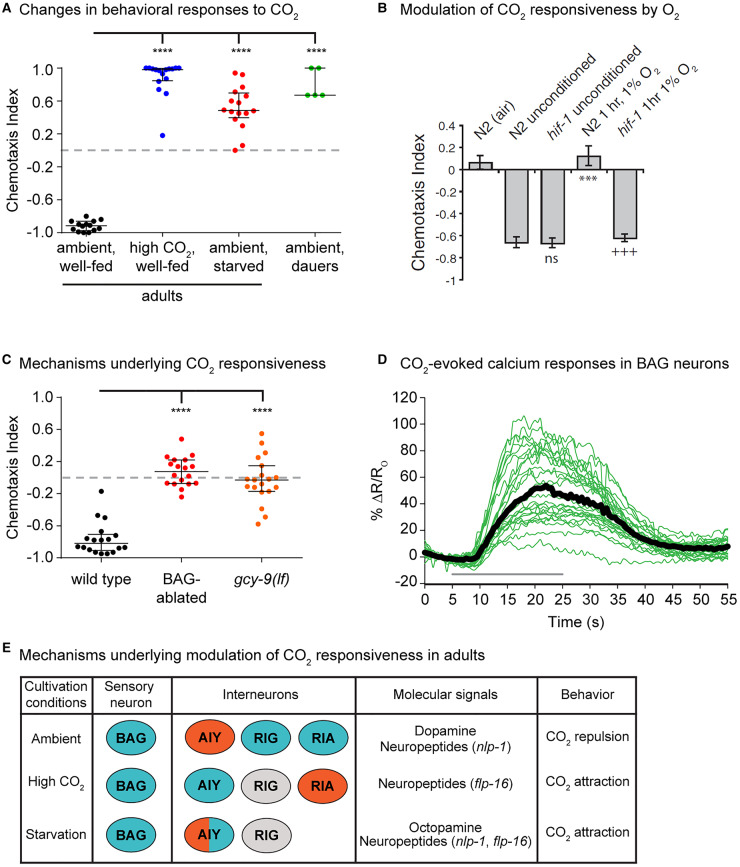
Behavioural responses of C. elegans to CO2. (A) Responses of wild-type C. elegans adults and dauers to CO2 in a chemotaxis assay (Fig. 1A). Dauers are developmentally arrested third-stage larvae that are similar to parasitic iL3s and IJs (Hotez et al., 1993; Viney et al., 2005; Crook, 2014). Animals were either well-fed adults cultivated at ambient CO2, well-fed adults cultivated at high CO2, starved adults cultivated at ambient CO2 or dauer larvae cultivated at ambient CO2. Adults were tested in a 20 min assay; dauer larvae were tested in a 1 h assay. Responses shown are to 2.5% CO2 (for adults cultivated at high CO2) or 10% CO2 (for all other conditions). For the high CO2 condition, adults were cultivated at 2.5% CO2 for one generation prior to the assay. For the starvation condition, adults were starved for 3 h prior to the assay. Data are from Guillermin et al. (2017), Rengarajan et al. (2019) and Hallem et al. (2011a). ****P < 0.0001, one-way ANOVA with Dunnett's post-test. The graph shows medians and interquartile ranges. (B) Previously experienced hypoxic conditions modulate CO2 responsiveness in C. elegans adults. Animals cultivated at low (1%) oxygen for 1 h prior to assays showed decreased CO2 avoidance. This change is mediated by hypoxia inducible factor-1 (HIF-1), since hif-1 mutants are not affected by prior O2 exposure. ns, not significant relative to N2 (wild-type); ***P < 0.001 relative to N2; +++P < 0.001 relative to N2 exposed to 1% O2 for 1 h. The N2 (air) condition represents a control condition in which animals were not exposed to a CO2 gradient. The graph shows means and SEMs. Figure is from Bretscher et al. (2008), copyright 2008 National Academy of Sciences. (C) The BAG sensory neurons and GCY-9 are required for CO2 repulsion in C. elegans. BAG-ablated animals and gcy-9 loss-of-function (lf) mutants are neutral to CO2. ****P < 0.0001, one-way ANOVA with Dunnett's post-test. The graph shows medians and interquartile ranges. Data are from Carrillo et al. (2013). (D) Calcium activity in BAG neurons in response to 10% CO2, as measured using the ratiometric calcium indicator yellow cameleon 3.60 (YC3.60). Green traces show responses of individual neurons; black line shows median response. Data are from Rengarajan et al. (2019). (E) A model for experience-dependent modulation of CO2 responsiveness in C. elegans adults. Under ambient conditions, CO2 repulsion is mediated by activation of the RIA and RIG interneurons and inhibition of the AIY interneurons, and by both dopamine and neuropeptide signalling involving the neuropeptide gene nlp-1. CO2 attraction in animals cultivated at high CO2 is mediated by activation of AIY, inhibition of RIA and silencing of RIG, as well as neuropeptide signalling involving the neuropeptide gene flp-16. Finally, CO2 attraction in starved adults is mediated by silencing of RIG and by a change in AIY responses such that activation and inhibition are observed with approximately equal frequency. Octopamine signalling and neuropeptide signalling via the neuropeptide genes nlp-1 and flp-16 also promote CO2 attraction during starvation. Blue = excitatory activity, orange = inhibitory activity, grey = silencing of activity. Figure is adapted from Guillermin et al. (2017) and Rengarajan et al. (2019).